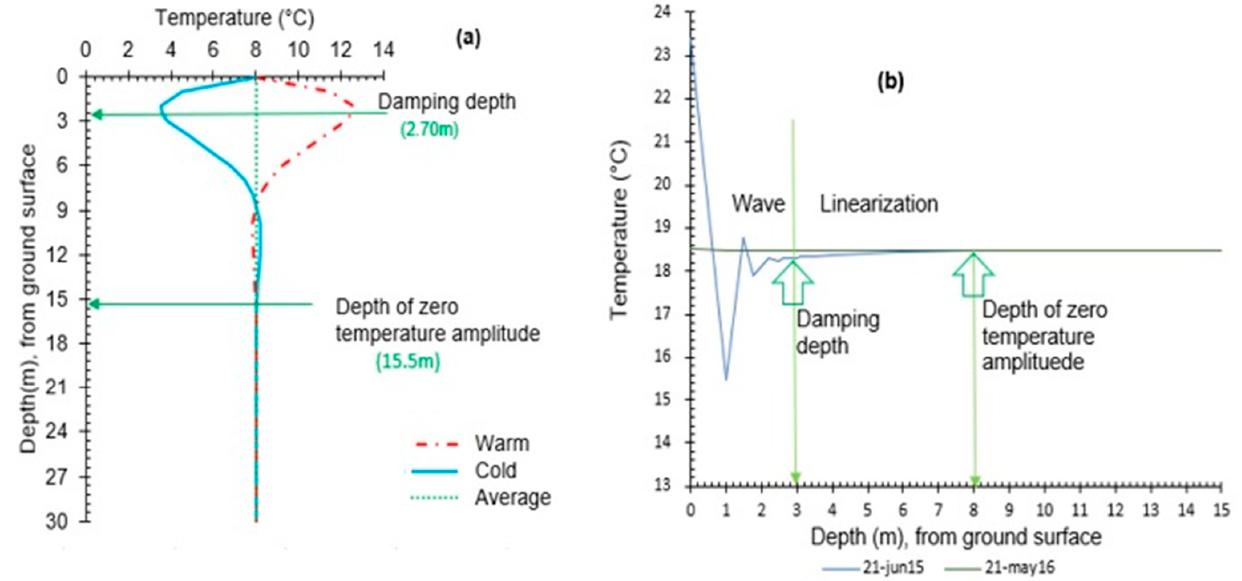
Figure 2. Ground temperature distribution showing the damping depth and the depth of zero temperature amplitude, with ( a ) annual ground temperature profile span and ( b ) components of the daily oscillatory ground temperature influenced by surface temperature variations diffusing in the shallow subsurface.